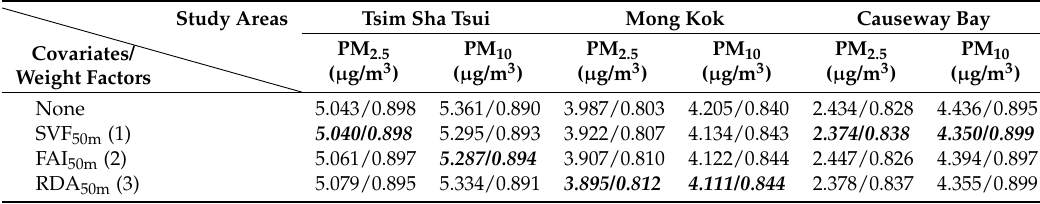
Table 4. The comparison of the RMSE/ R 2 of PM concentration levels by the consideration either k − fold on different weight factors or different covariates. The method produces the minimum RMSE and the highest R 2 values of the PM 2.5 and PM 10 estimation of the three study areas were k − fold